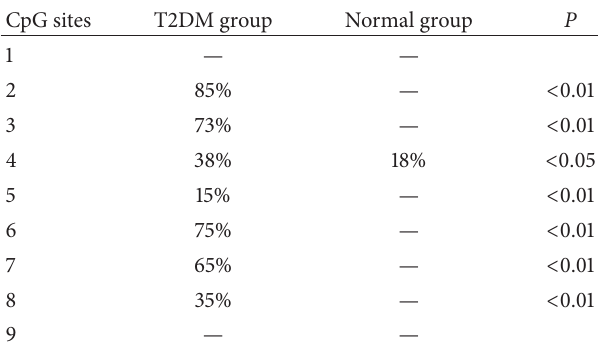
Table 1: The probability of each CpG of